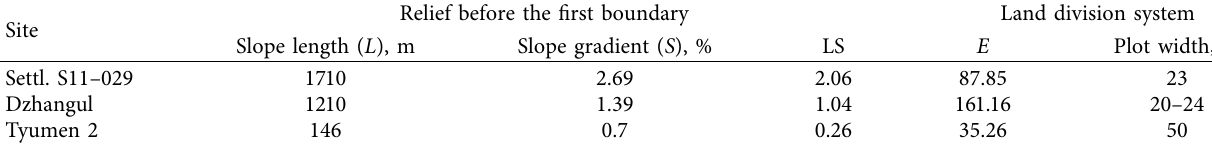
Table 1: Characteristics of relief outside the land plots and the basic parameters of the division system. Site Dzhangul